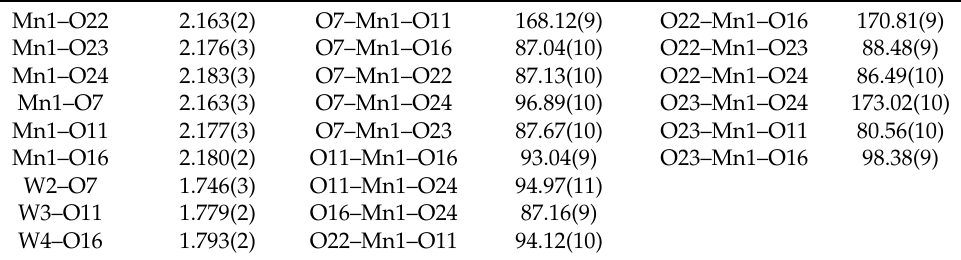
Table 1. Bond lengths (Å) and angles (deg.) for 1